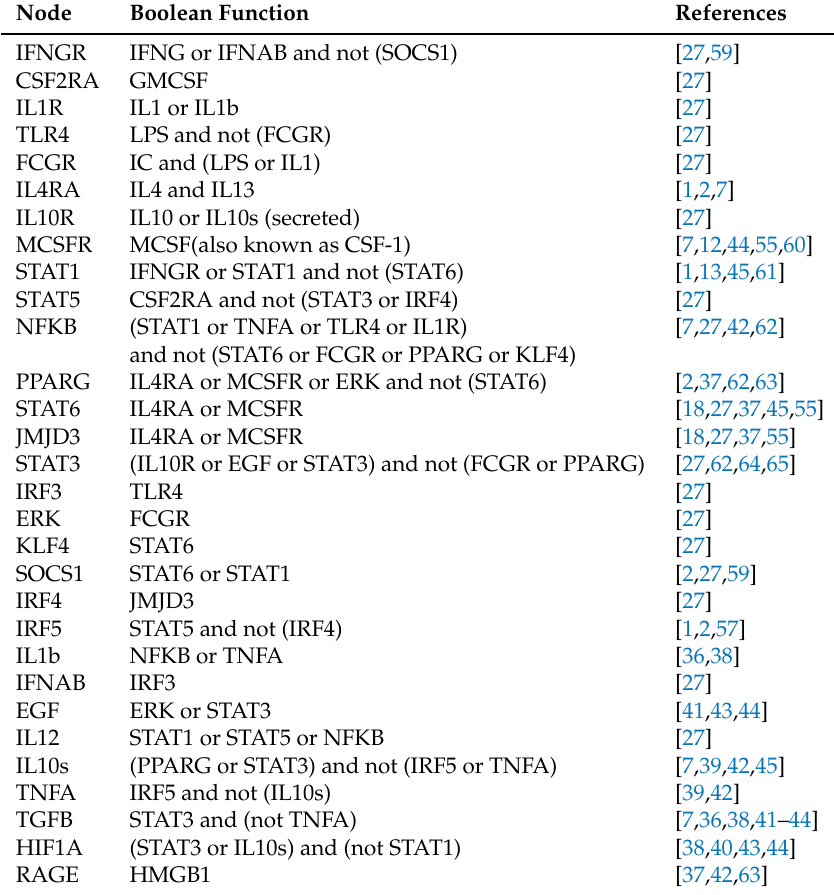
Table 2. Boolean rules of the 30 intra-cellular nodes of the macrophage polarization network (Table